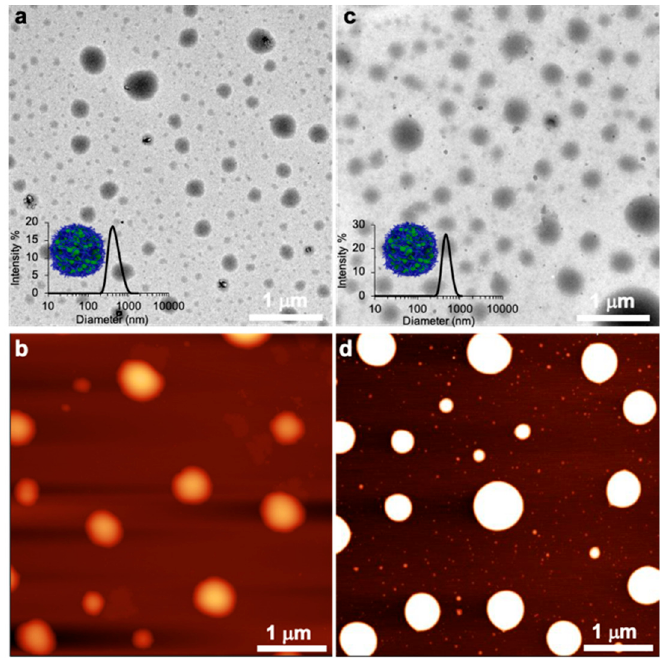
Figure 3. ( a , b ) TEM and AFM images of P1 . Inset showing the DLS data and a cartoon representa- tion of the particles. ( c , d ) TEM and AFM images of P2 . Inset showing the DLS data and a cartoon representation of the